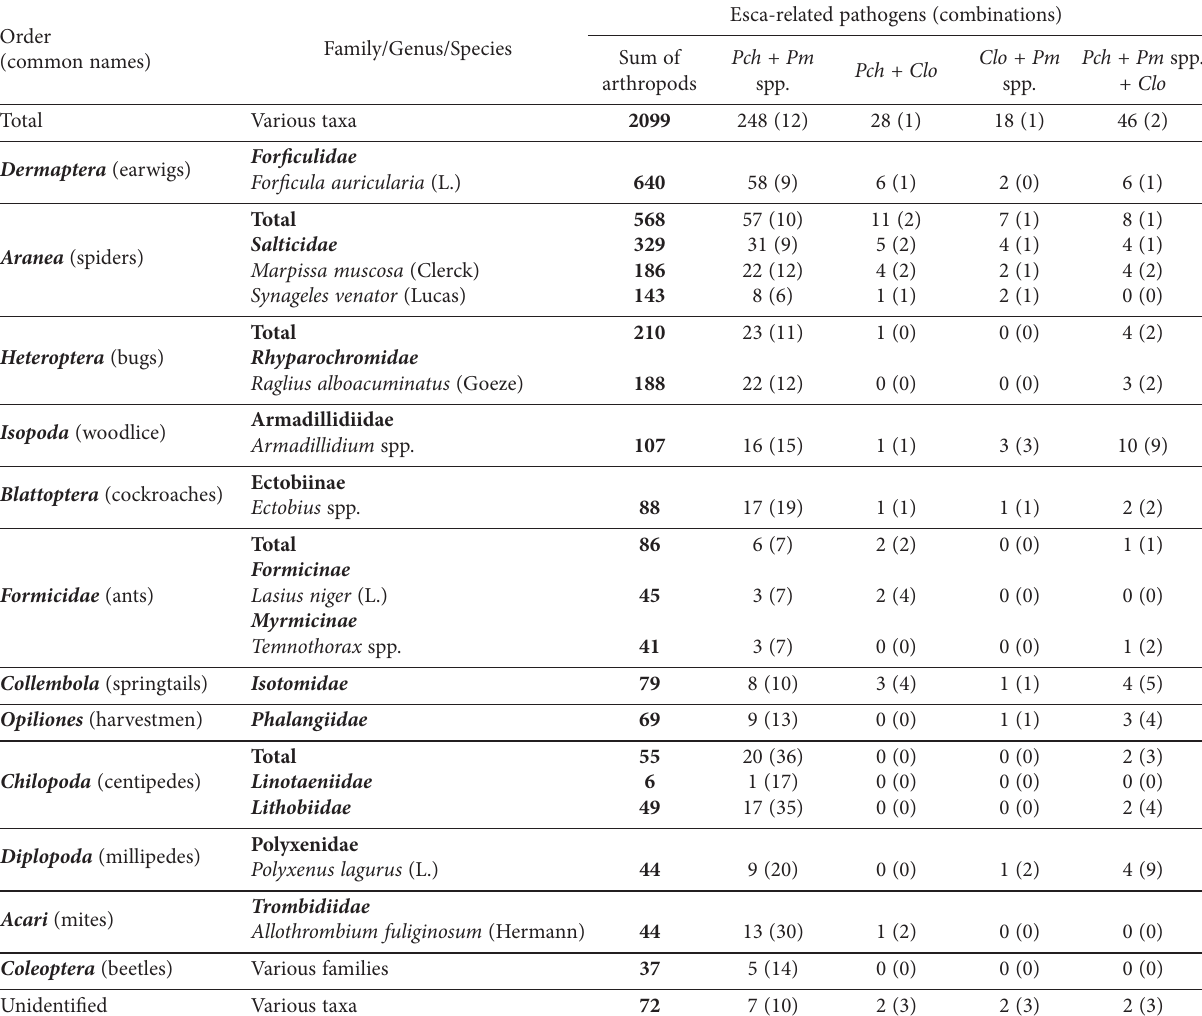
Table 2. Overview of arthropods testing positive for more than one of the esca-related pathogens Phaeomoniella chlamydospora ( Pch ), Phae- oacremonium spp. ( Pm spp.) and Cadophora luteo-olivacea ( Clo ). Species identity only given for most frequent and representative arthro-